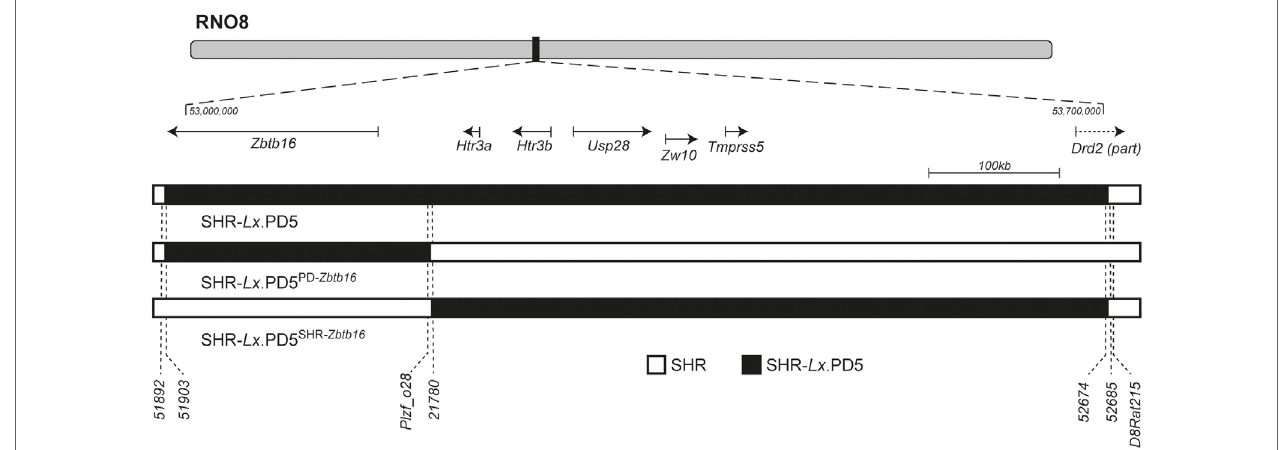
FigUre 1 | The rat chromosome 8 (RNO8) differential segments in SHR- Lx .PD5 congenic strains. The schematic representation of RNO8 with indication of the relative position and extent of the differential segments in the congenic strains is shown at the top. The portrayed region corresponds to the interval between 53